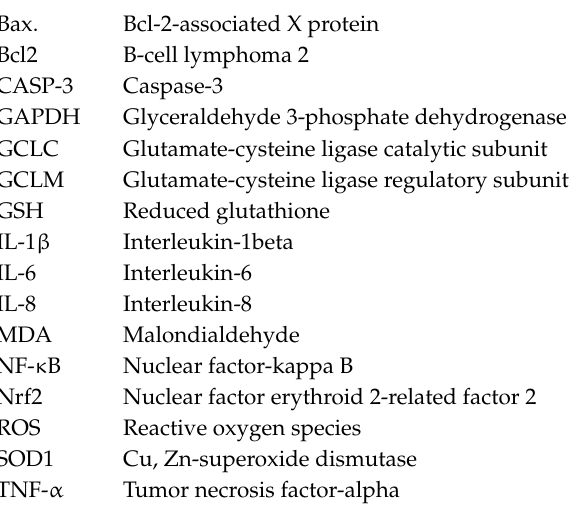
4348 / s1, Figure S1: Chemical structure of quercetin, Table S1: Ingredients of basal diet, Table S2: Antibodies, sources, working dilutions, and conditions for antigen retrieval (10 mM citrate bu ff er at pH 6.0), Table S3: Primers’ sequences for